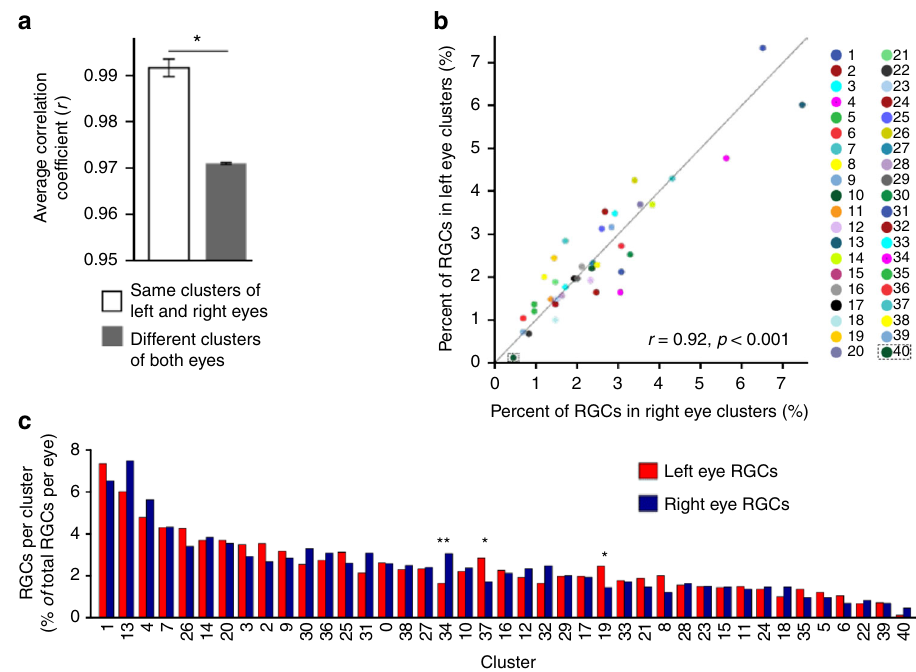
Fig. 2 Distribution of RGC subtypes by left/right eye. a Mean correlation coef fi cient between gene expression pro fi les of the same clusters in the left and right eyes is signi fi cantly higher than mean correlation coef fi cient between gene expression pro fi les of different clusters from both eyes (mean ± SEM shown, Pearson r , 2-tailed; * p < 0.0001 by independent samples t -test, 2-tailed). b Percent of RGCs per cluster is shown relative to the total RGCs in the left (red) or right (blue) eye. The bars are ranked from higher to lower based on the average percent of cells per cluster from both eyes. Signi fi cant (* p < 0.01 and ** p < 0.001) clusters enrichments per eye are shown (statistical analysis described in Methods section). c Percent of RGCs comprising left and right eye clusters is highly correlated, r = 0.92, p < 0.001 (Pearson,